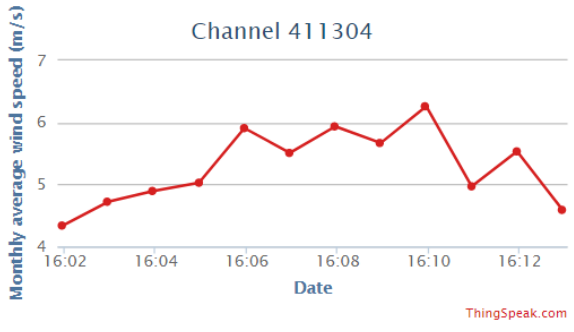
Figure 8: Wind speed distribution